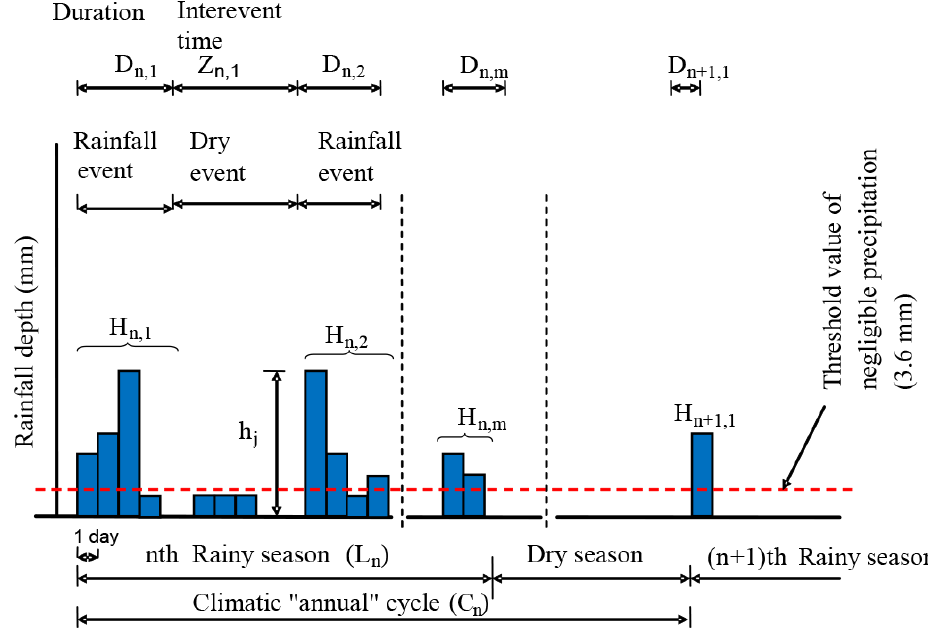
Figure 2. Dry and wet spell (year) representation.